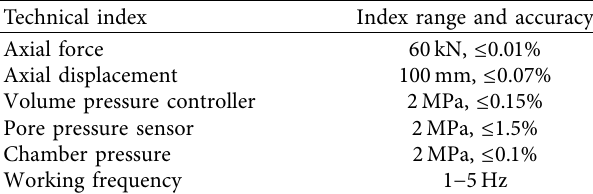
Table 1: Technical index of the dynamic triaxial